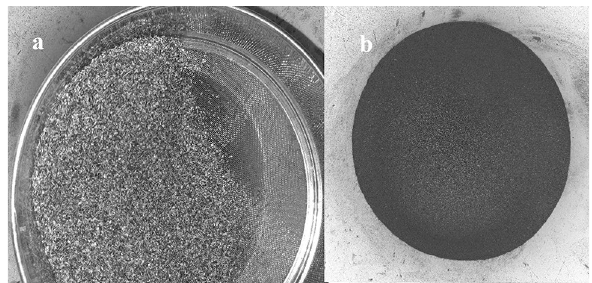
Figure 9. Sieving ( a ) and resulting sieved ash ( b ) at a diameter < 0.5 mm.